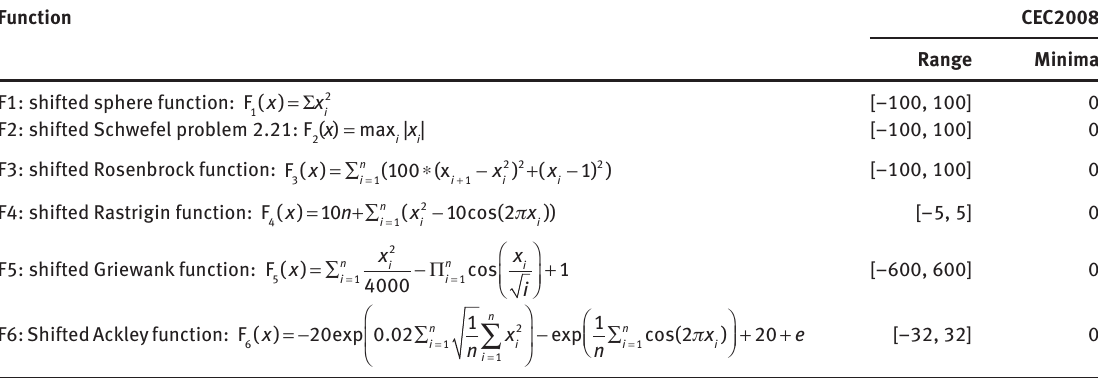
Table 4: CEC2008 Benchmark Test Problems. Function